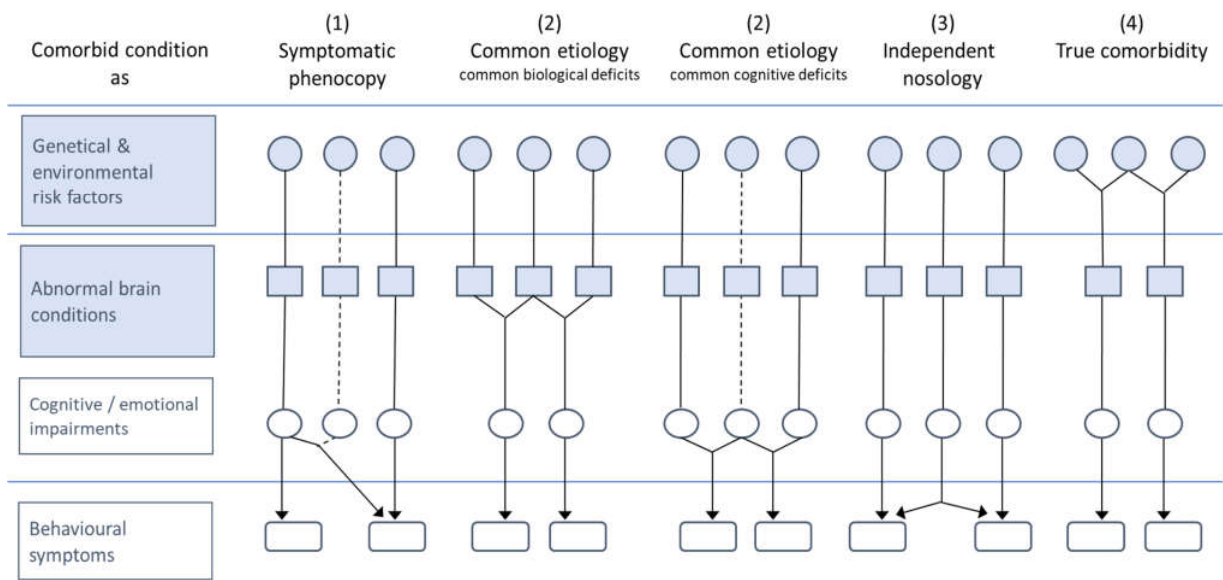
Figure 1. Models of comorbidity (adapted from Banaschewski et al. [15]; with permission of Springer). In the present article, only levels “Genetical/environmental risk factors” and “Abnormal brain conditions” are considered.